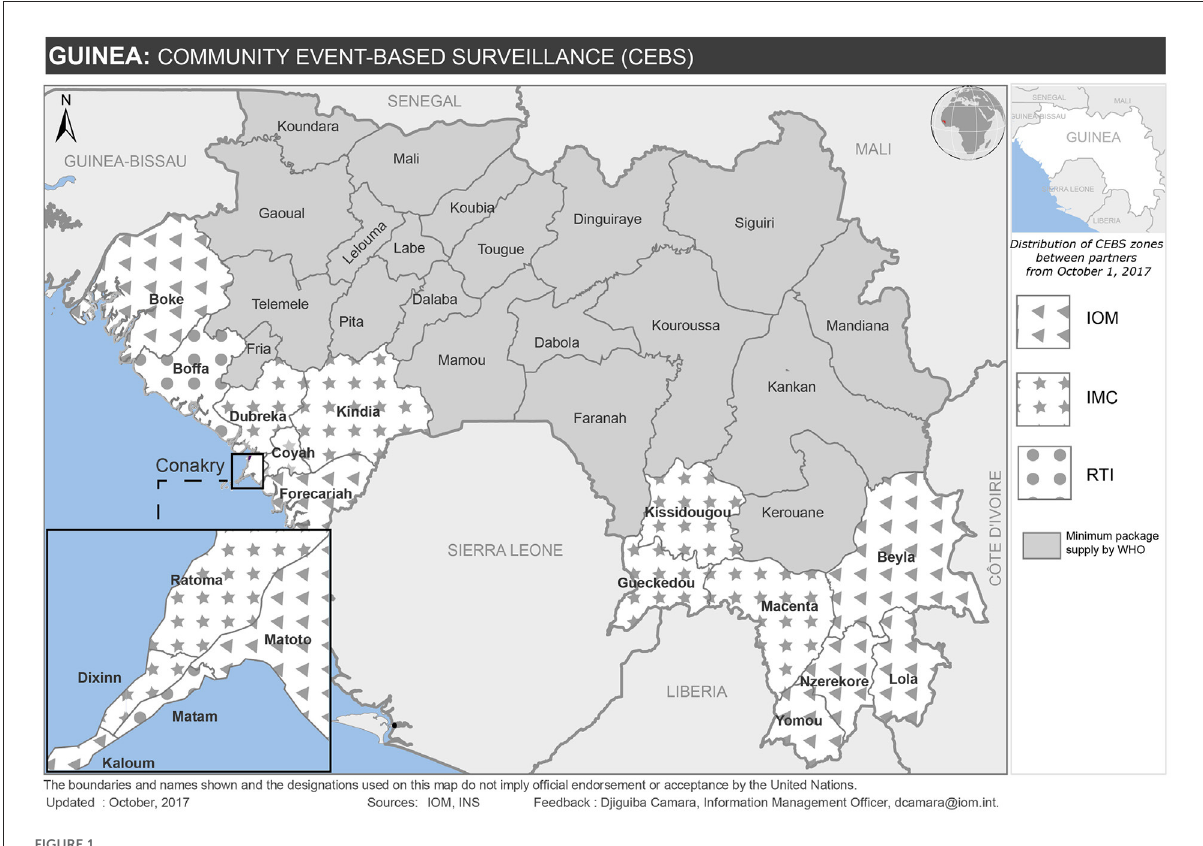
FIGURE1 Distribution of US CDC partners implementing CBS in Guinea,